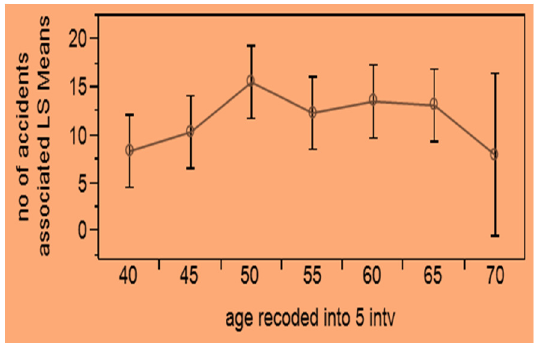
FIG. 3: NUMBER OF ACCIDENTS ASSOCIATED LS